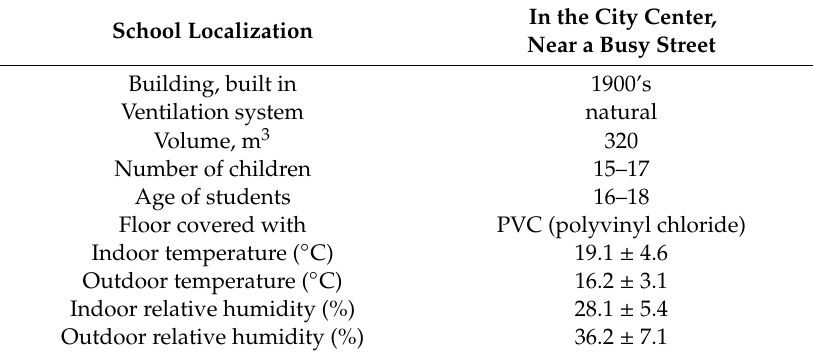
Table 1. Environmental parameters and description of the analyzed gymnastic